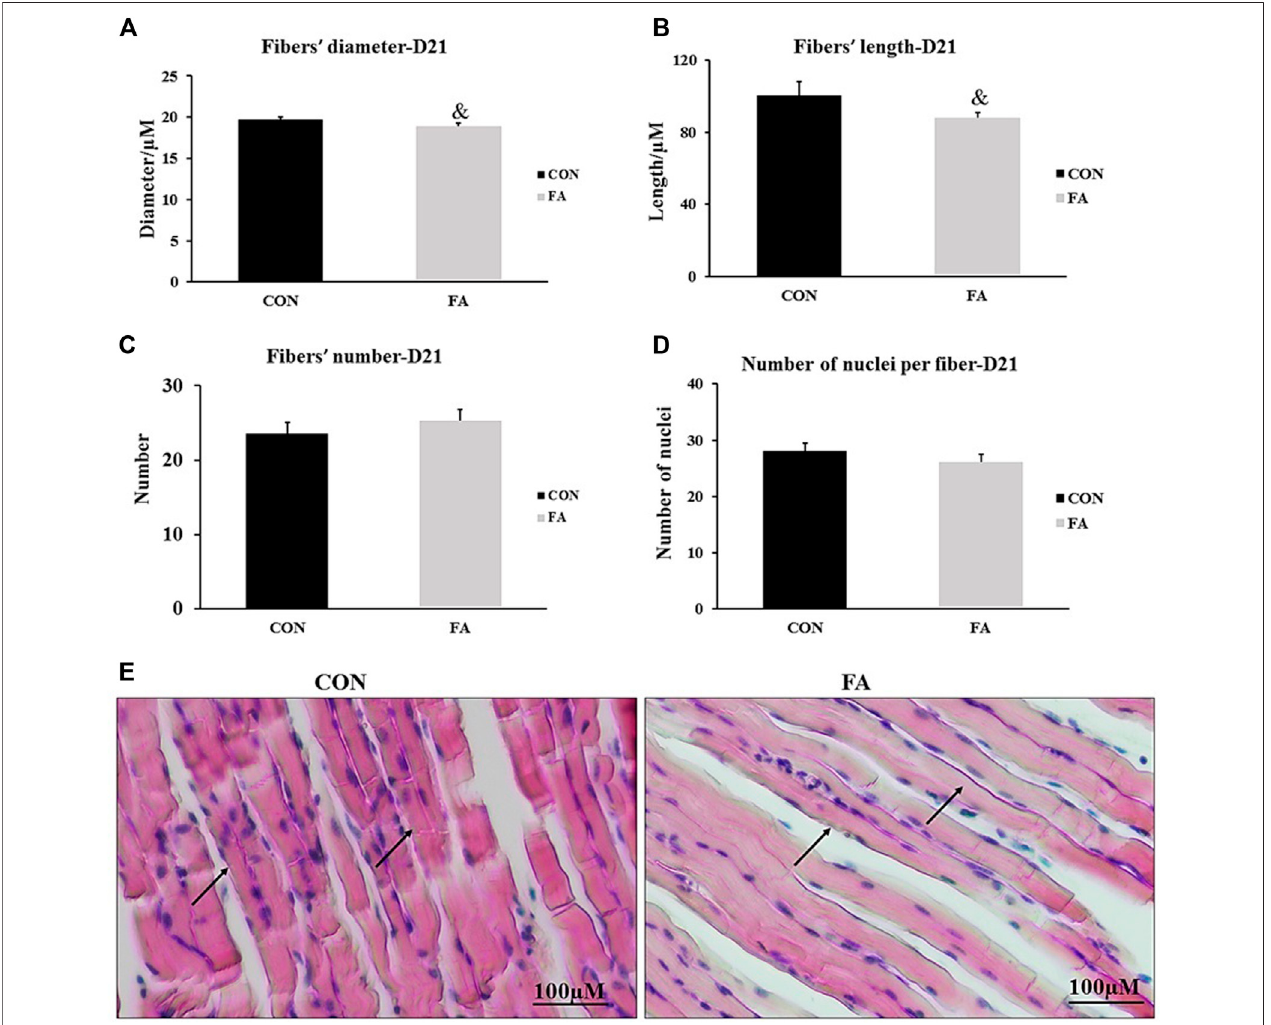
FIGURE 8 | Effect of maternal intake of EPA/DHA on myotubes formation in day 21 weaned mice. The mothers were fed either control diet (CON) or EPA/DHA enriched diet (FA) during the entire period of pregnancy and lactation. (A) Data shows the difference in the diameter of muscle fi bers measured in micrometer between CONandFAgroups. (B) Datashowsthedifferenceinthelengthofmuscle fi bersmeasuredinmicrometerbetweencontrolCONandFAgroups. (C) Thedifferenceinthe number of muscle fi bers in the cross-sections between CON and FA treated groups. Images were analyzed in ImageJ-FIJI using the Freehand Selection Tool to encircleindividualmyo fi bers. (D) Thedifference inthenumberofnucleipermuscle fi berbetweenCONand FAgroups. Thedatarepresentasmean±SEM. p < 0.05( n = 8); eight samples per group were used in this measurement where the value of each sample represents the average of the measurements of 8 cross section areas randomly selected from each sample (E) a representative microscopic image of muscle tissue stained with H&E stain from differentially treated group. The magni fi cation is ×10 and scale bar is 100 μ m black arrows refer to muscle fi bers. Non-signi fi cant difference was observed between groups.